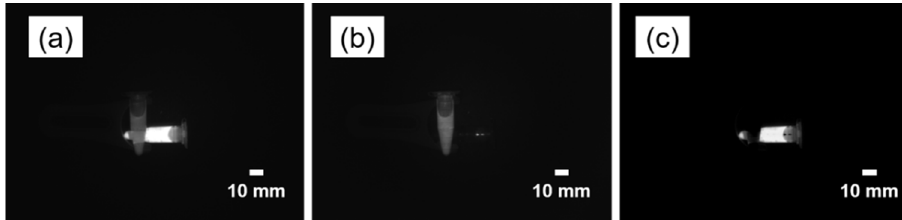
Figure 9. NIR Fluorescence images of crossed two contrast agents: methylene blue and indocyanine green. ( a ) NIR 1 image under 680 nm laser diode illumination and ( b ) NIR 2 image under 785 nm laser diode illumination, and ( c ) subtracted image by NIR 2 from NIR 1 image.